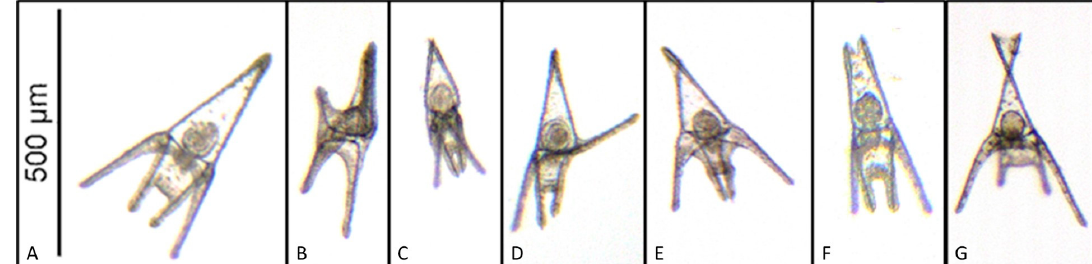
Figure 1. Various abnormalities observed in P. lividus larvae exposed for 48 h in control conditions and in four concentrations (1, 10, 50, 100 µ g / L) of glyphosate, AMPA and Roundup. ( A ) Normal echinopluteus; ( B , C ) deformed echinopluteus; ( D ) twisted post-oral rod; ( E ) unequally long somatic rods; ( F ) apically spaced somatic rods; ( G ) apically crossed somatic rods.